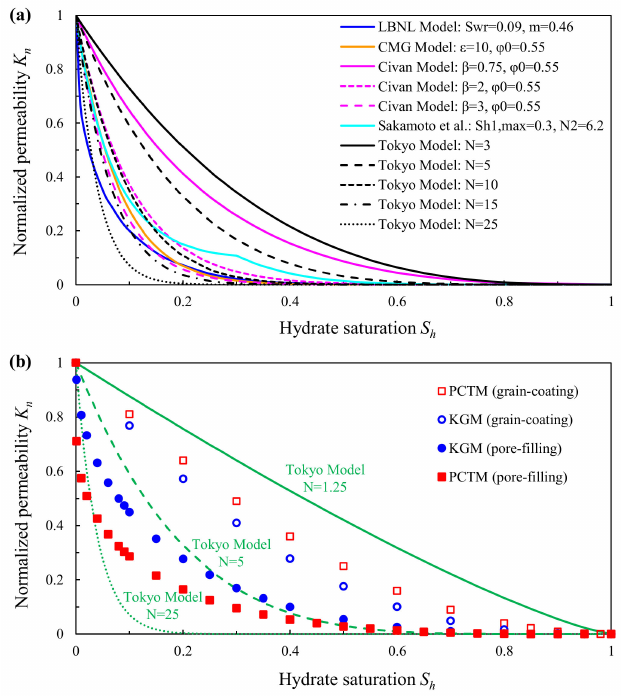
Figure 3. ( a ) The K n - S h relationships of various permeability models (i.e., reservoir simulator used models called in this paper); ( b ) changes in normalized permeability vs. hydrate saturation of